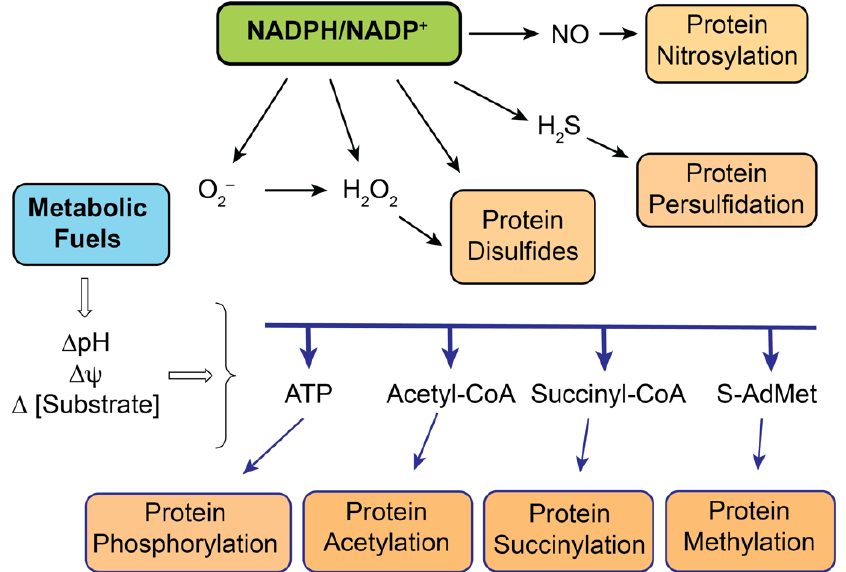
Figure 4. Involvement of mitochondrial metabolism and redox processes in the post-translational regulation of mitochondrial proteins and enzymes. The scheme illustrates the involvement of redox processes (acting through NADPH/NADP + ) and metabolic processes to produce several types of protein modifications that can alter protein structure and/or function. Abbreviations: S-AdMet: S-adenosylmethionine; NO: nitric oxide. Adapted from [29].